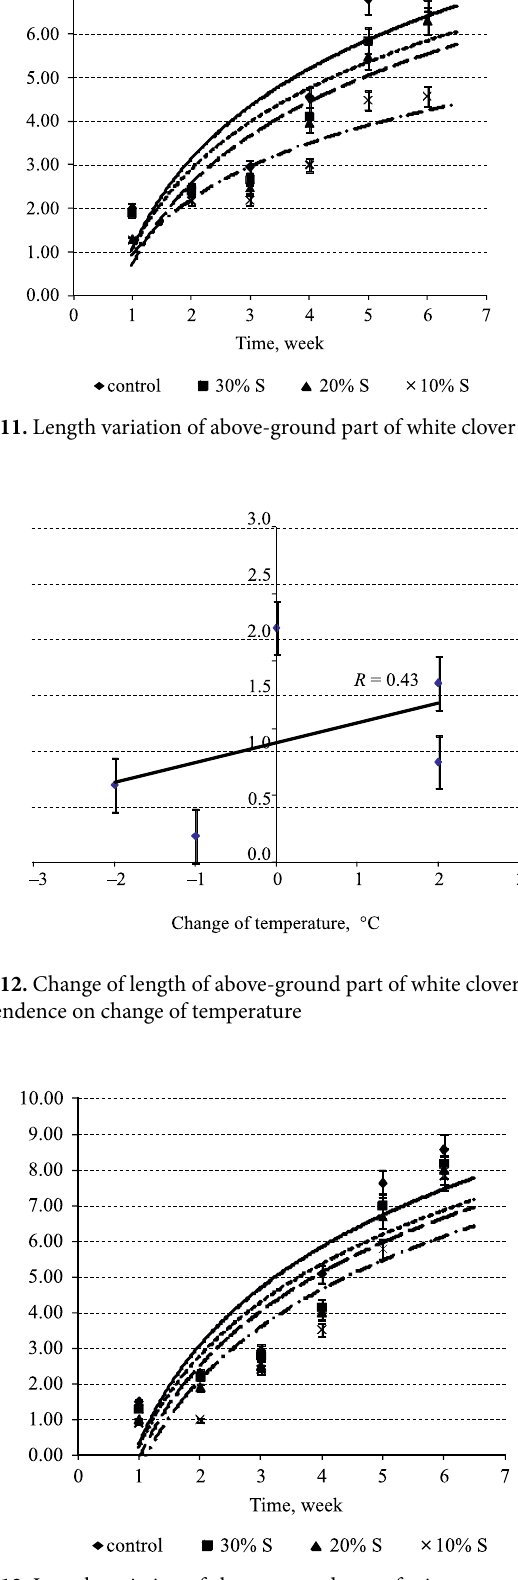
Fig. 13. Length variation of above-ground part of crimson